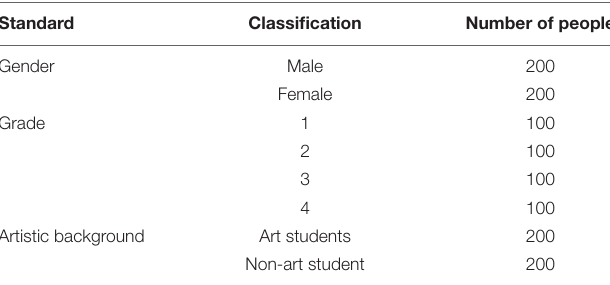
TABLE 1 | Basic classification information of Cinematography Major students.